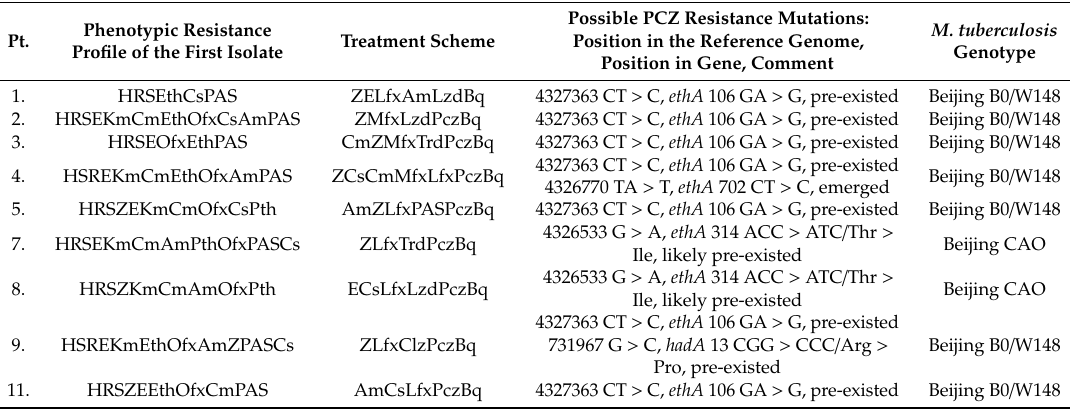
Table 1. Summary of enrolled tuberculosis patients and infecting M. tuberculosis isolates for patients treated with